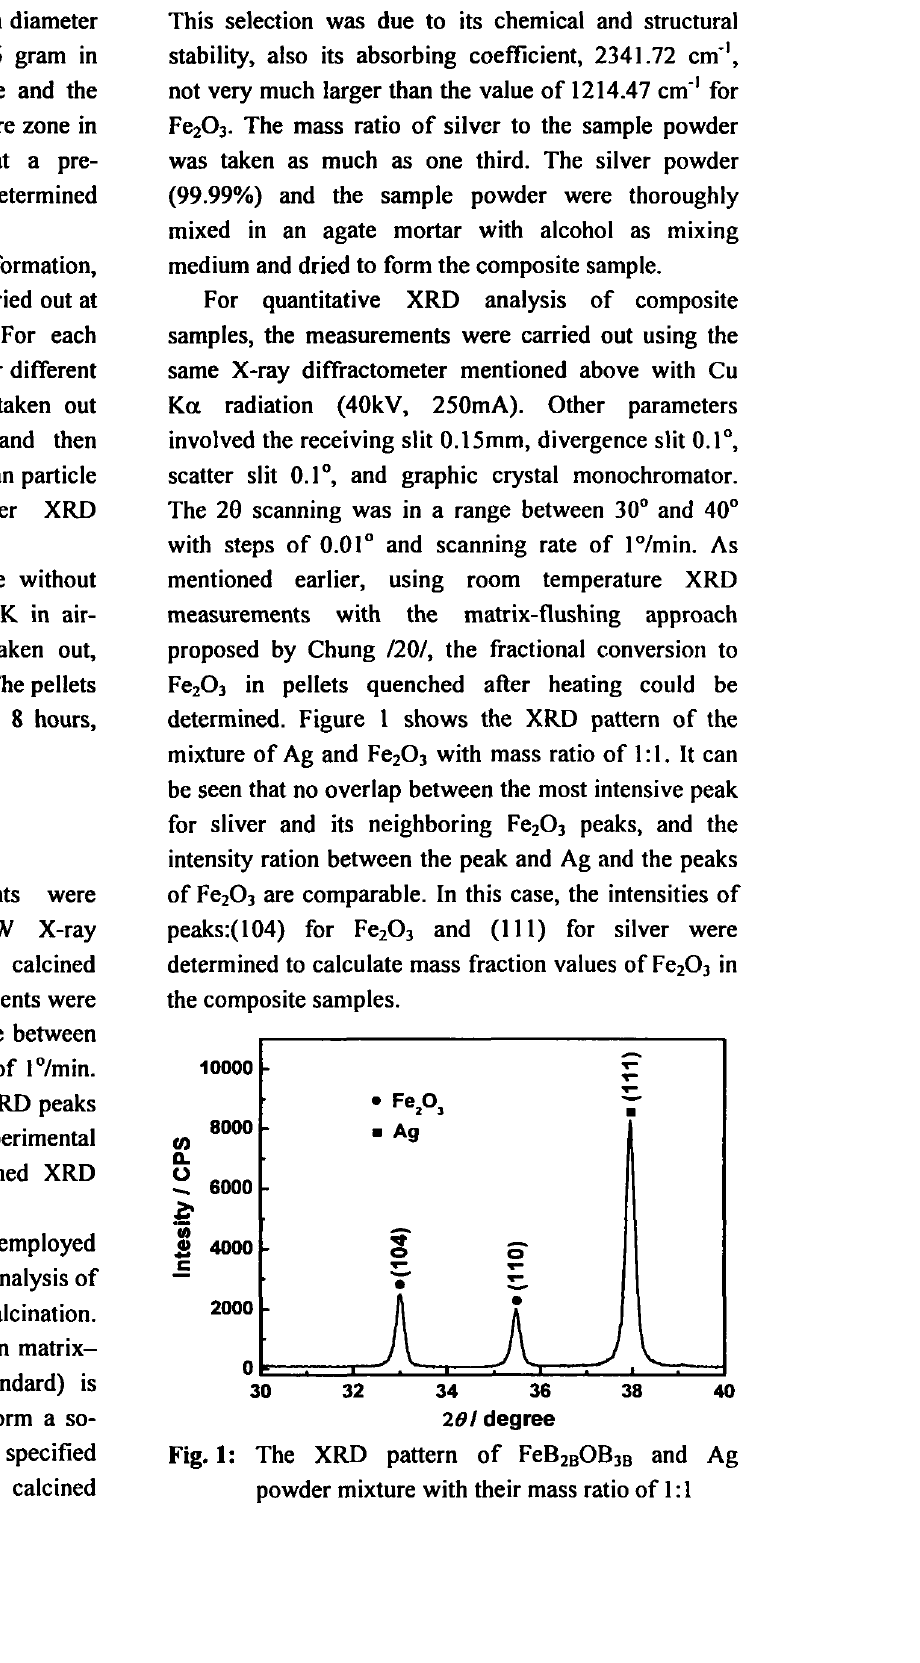
Fig. 1: The XRD pattern of FeB powder mixture with their mass ratio of